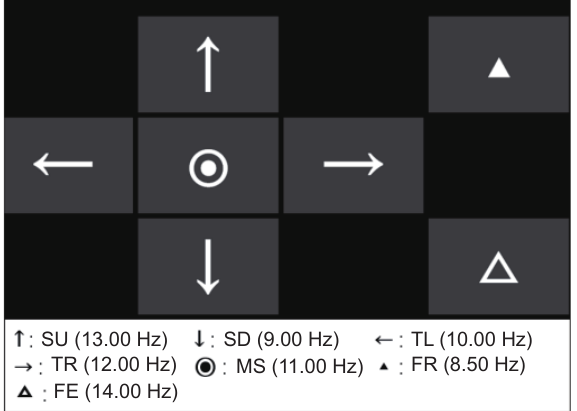
Fig. 2 Stimulus interface of BCI based on